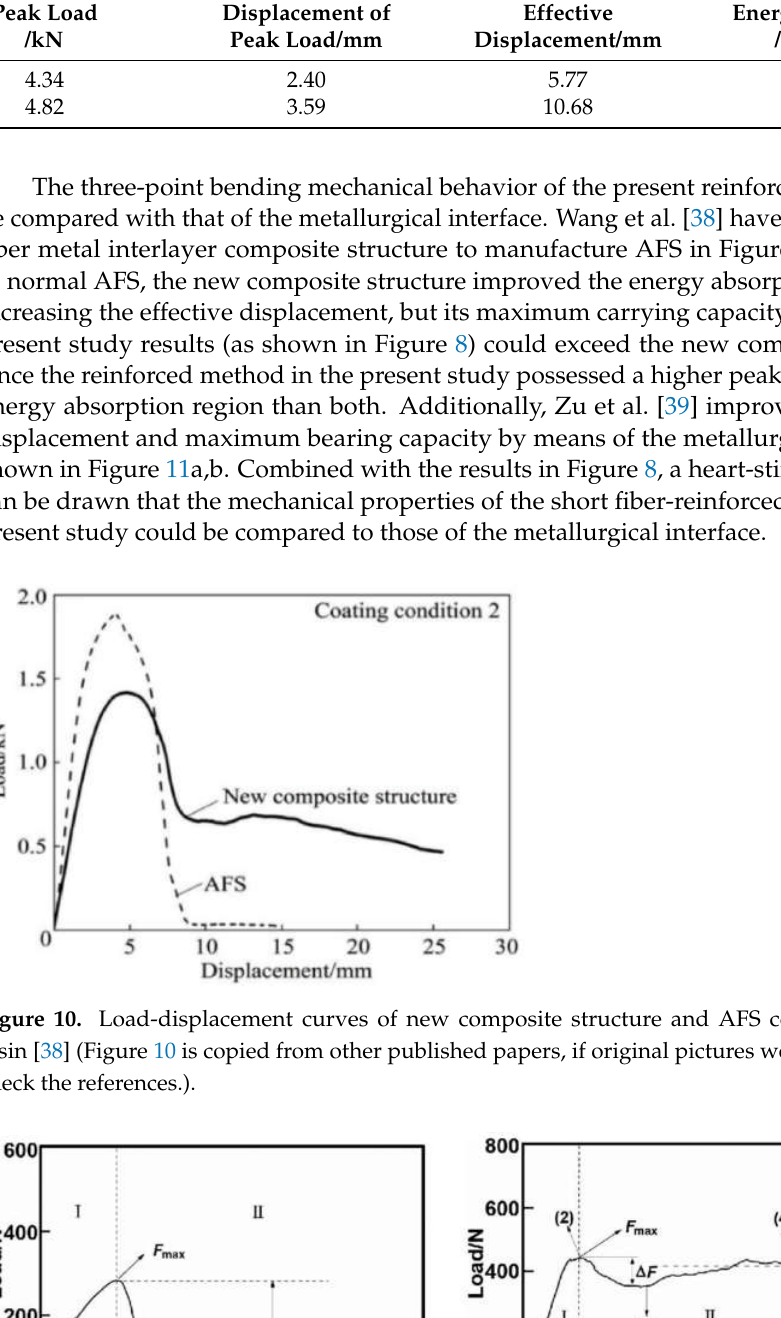
Figure 9. Deformation process from ( a ) to ( f ) of AFS after interface enhancement under three-point bending. Table 4. Peak load, displacement, effective displacement and energy absorption of each specimen.